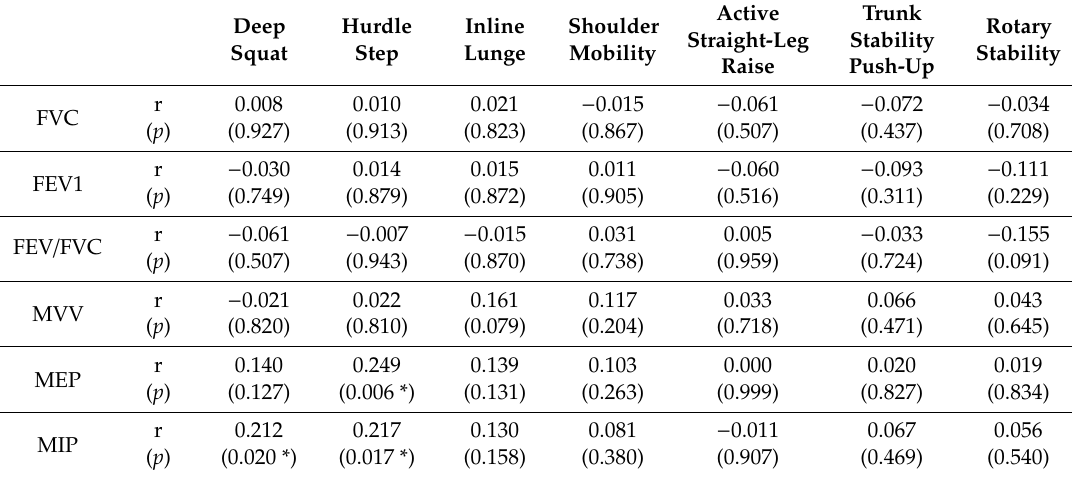
0.212 0.217 0.130 0.056 ( p ) (0.020 *) (0.017 *) (0.158) (0.380) (0.907) (0.469)